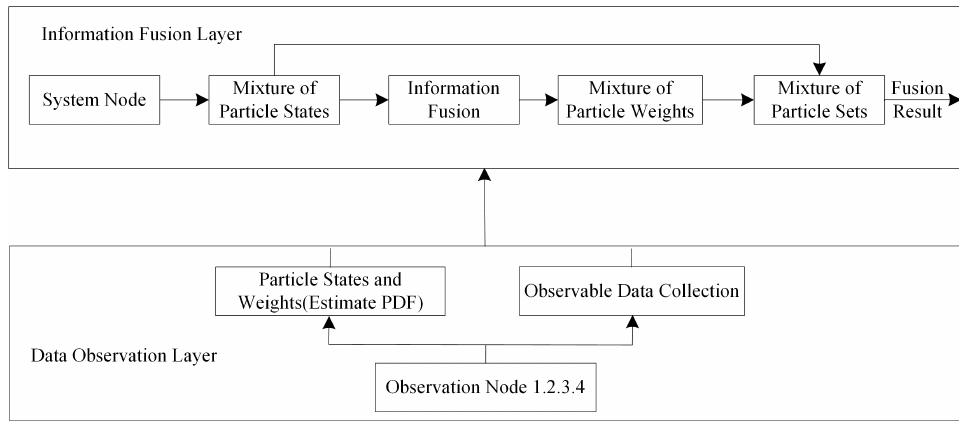
Figure 3. Processing procedure of multi-target tracking